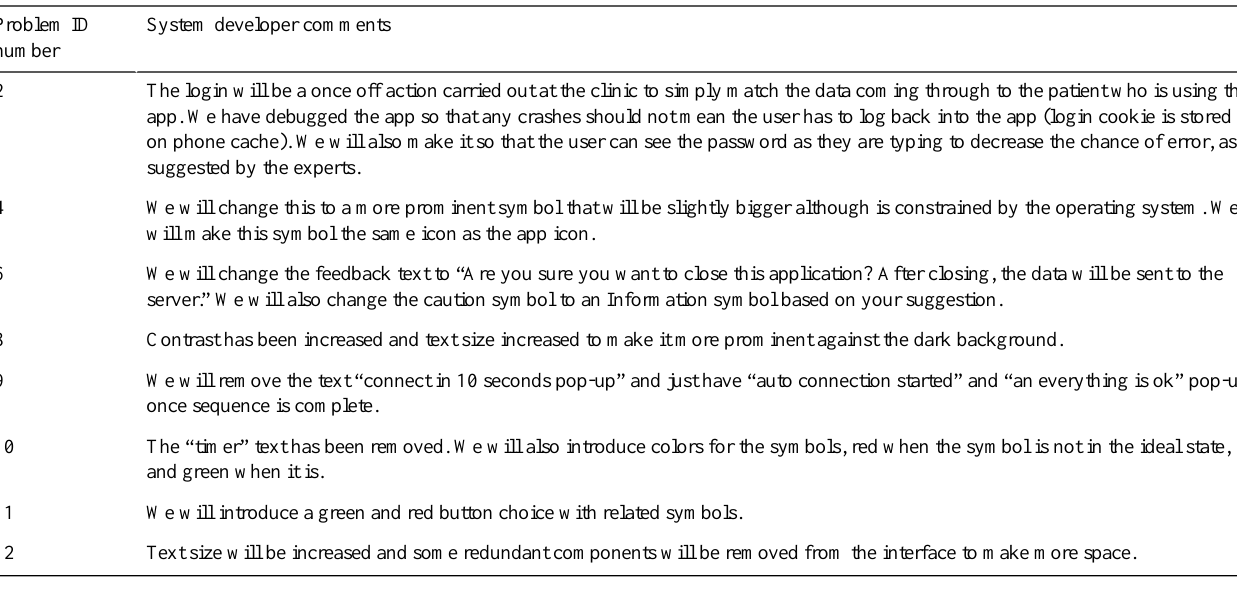
Table 8. Problems that were directly addressed by system